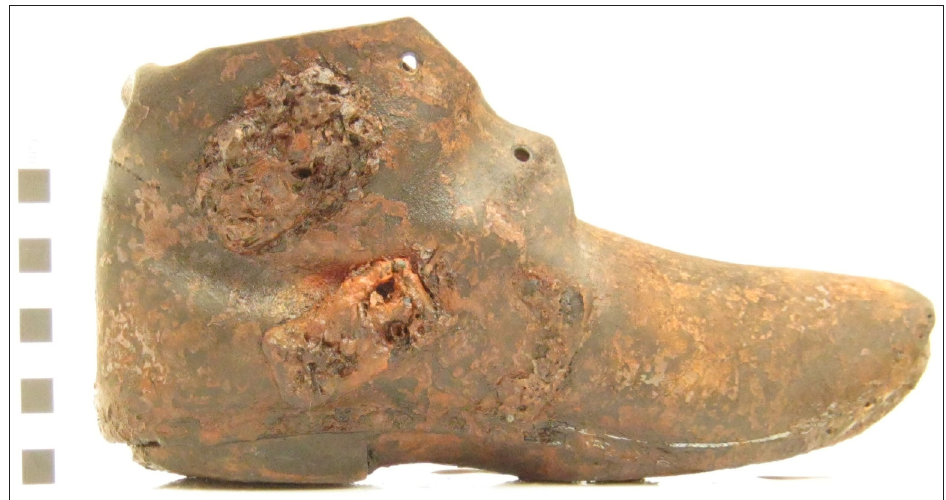
Fig. 1: A 19th-century, size 8, leather shoe found during excavation in London #fivestarfinds (© Archaeology South-East).